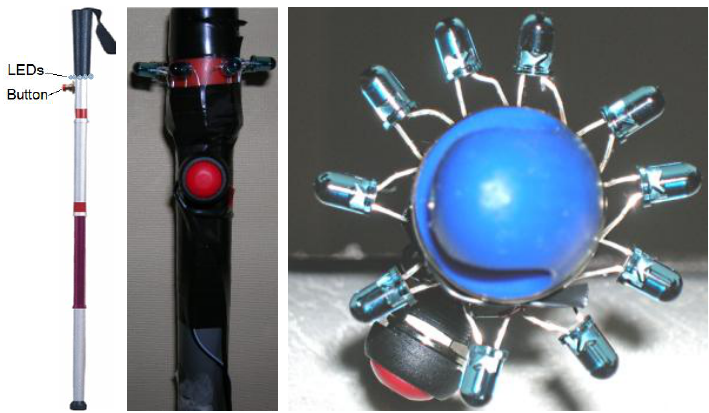
Figure 3. The augmented white cane.